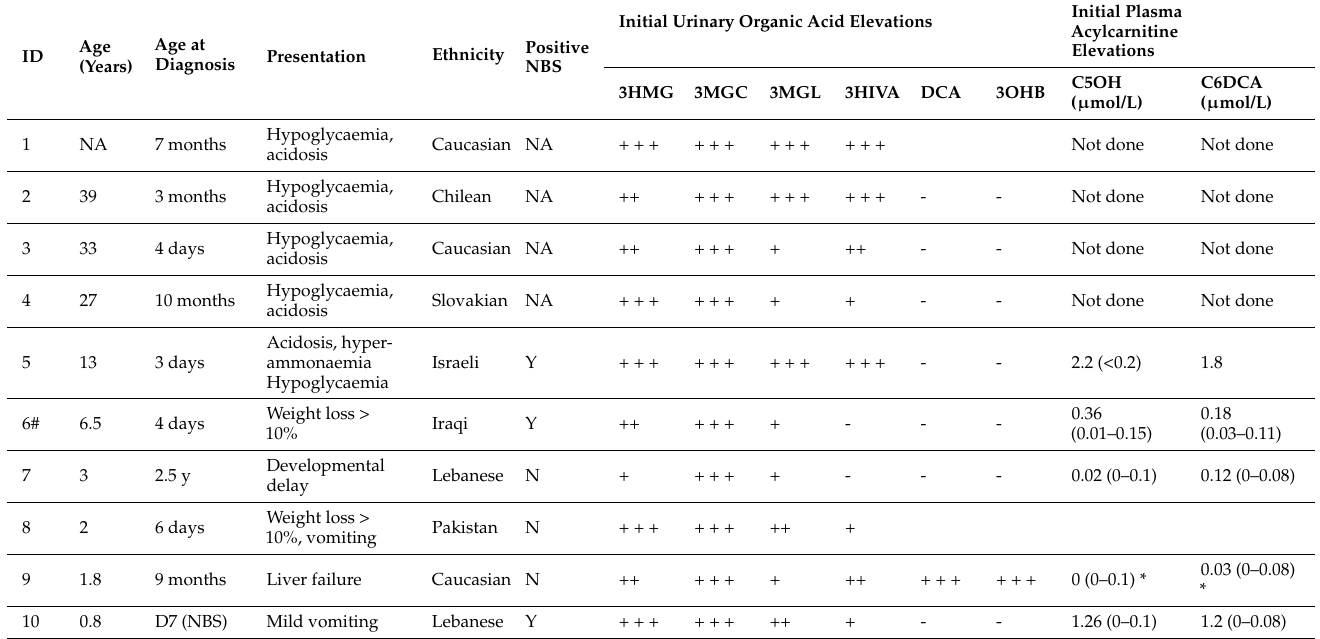
Table 1. Initial presentation of Australian patients with HMG-CoA Lyase